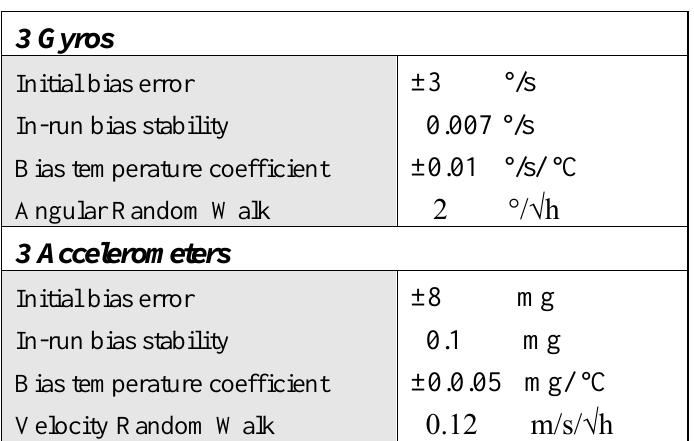
Table 1. ADIS16364 IMU specifications [13].